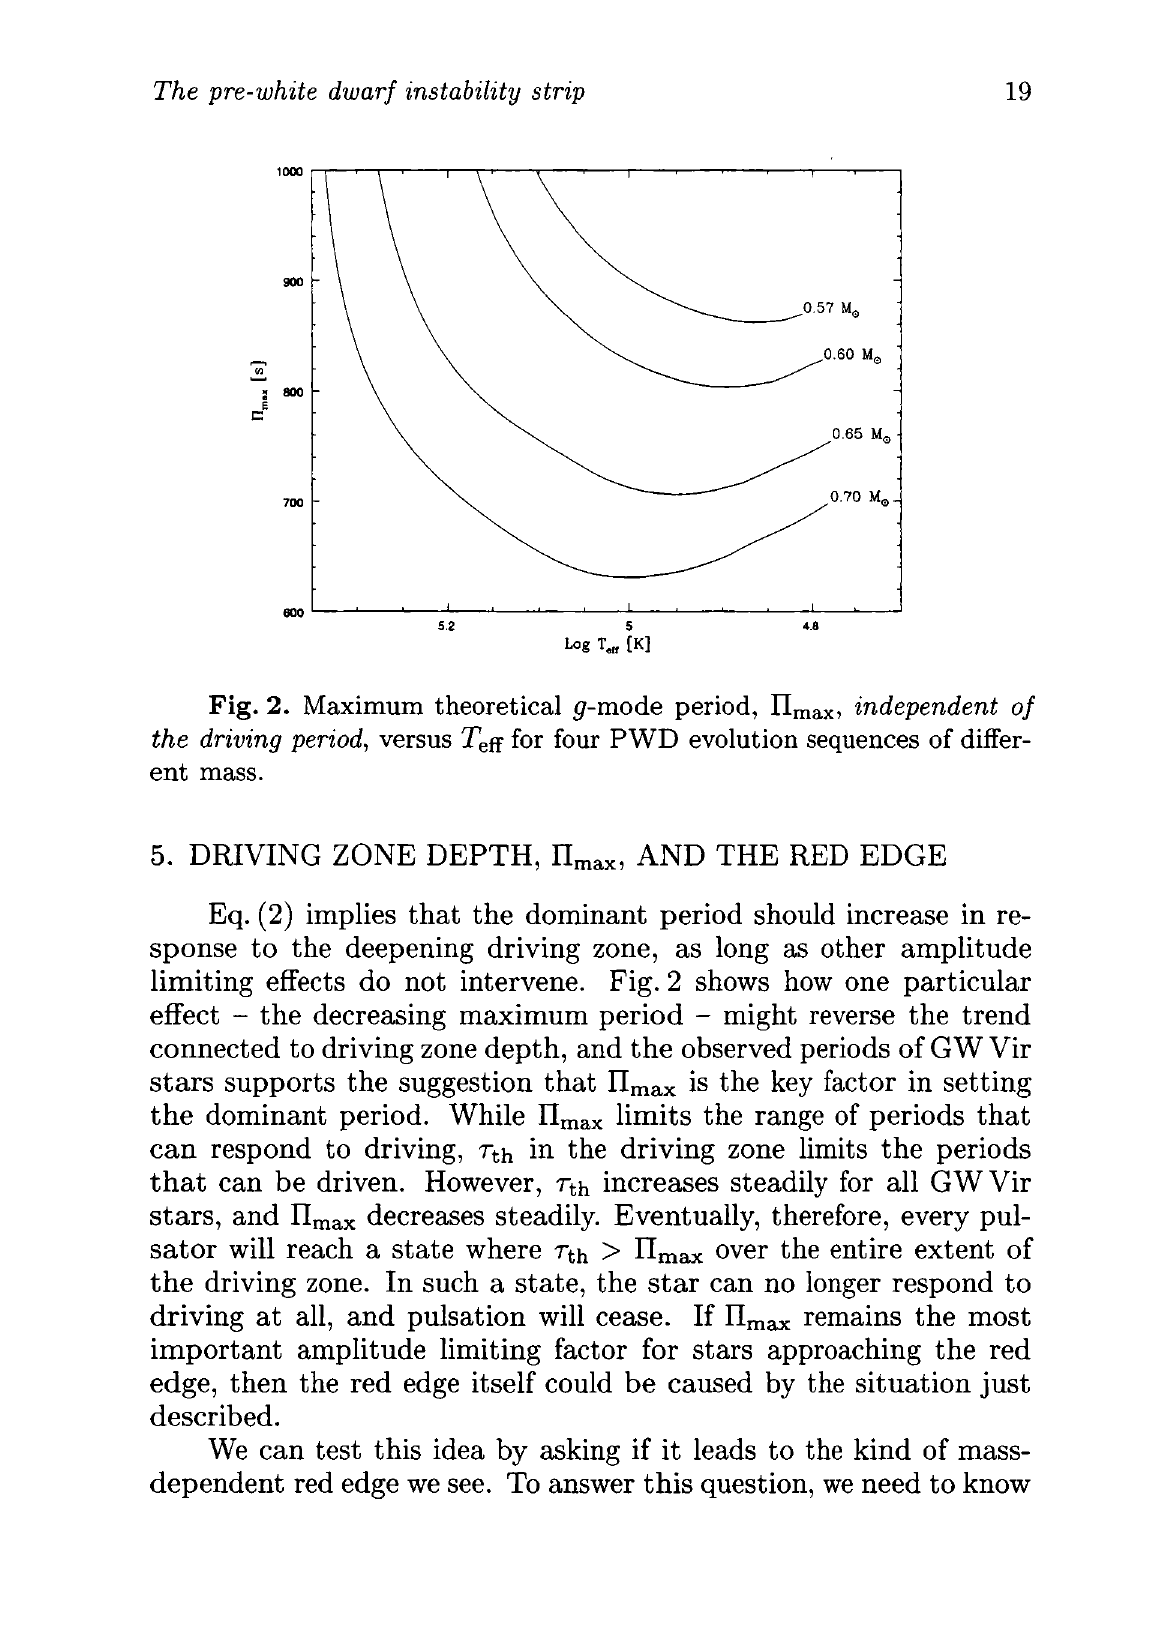
, independent of max